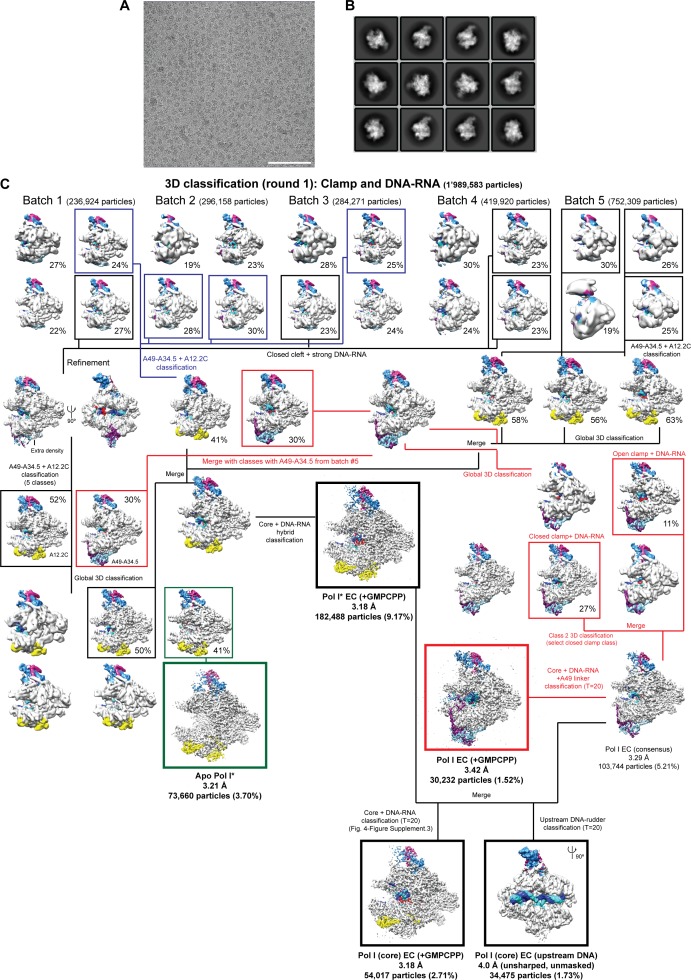
Cryo-EM data and processing.(A) Representative micrograph. Scale bar = 100 nm. (B) 2D class averages from the initial auto-picked particles. (C) Processing pipeline. The resolution, number of particles and percentage of particles with respect to the initial number of particles after 2D classification is shown below each class. The stalk subunits (A43–A14), the DNA-RNA, the heterodimer (A49-A34.5) and A12.2 are colored as in Figure 1.